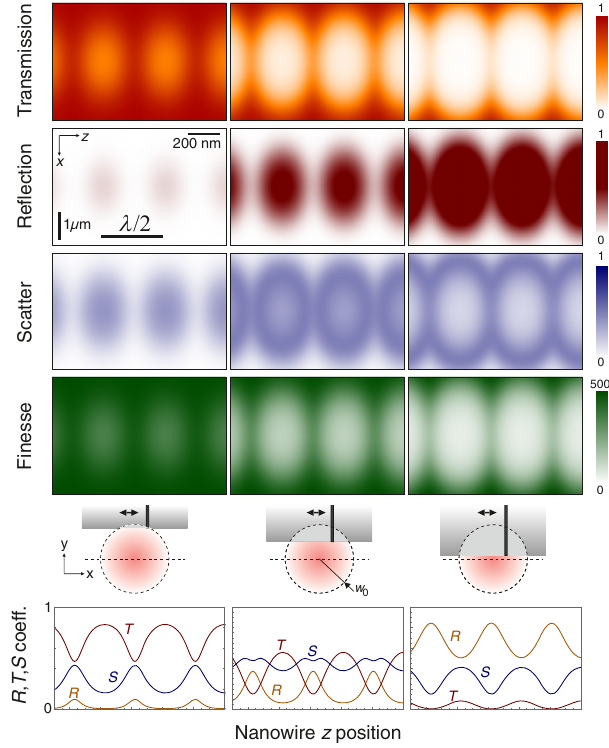
FIG. 15. Typical results of simulations. The transmitted, re- flected, and scattering coefficients, as well as the cavity finesse, are computed for various positions of the nanowire in the XZ plane and for three different vertical insertions in the mode volume. From left to right: the nanowire bottom extremity is located at 1.8, 1, and 0 . 2 μ m above the optical axis (optical waist of w 0 ¼ 1 . 8 μ m). The other bare cavity properties are 500 finesse, symmetric mirrors, and 12 μ m